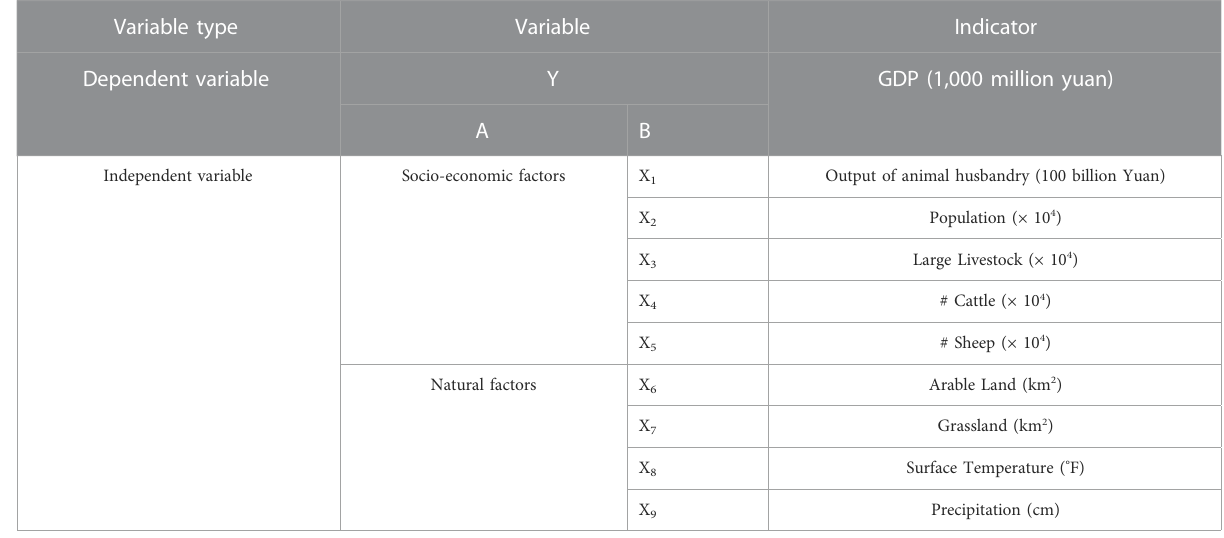
TABLE 2 Index evaluation